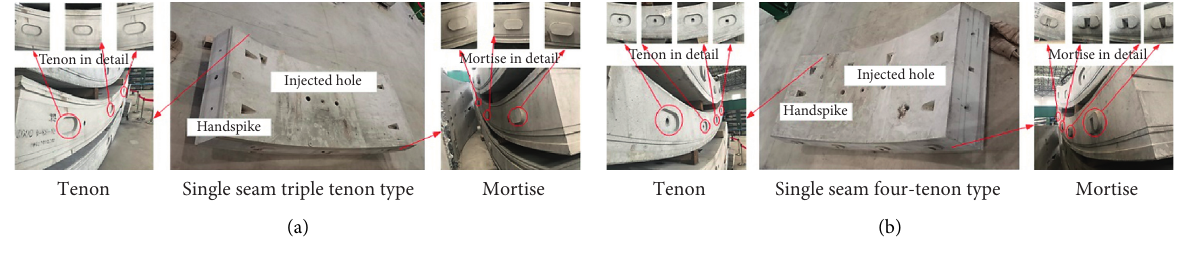
Figure 4: Segment layout. (a) Three-tenon type segments. (b) Four-tenon type segments.